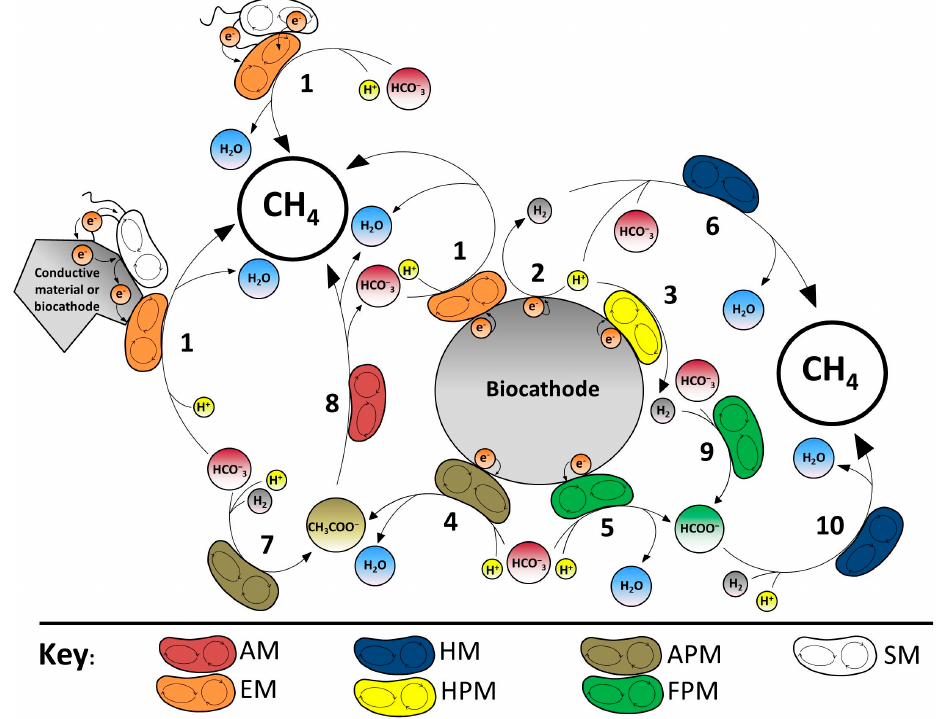
Figure 3. Described electromethanogenesis routes within mixed culture biocathodes. Sizes of the circles do not correspond to any proportions. 1. Direct electromethanogenesis; 2. Abiotic H 2